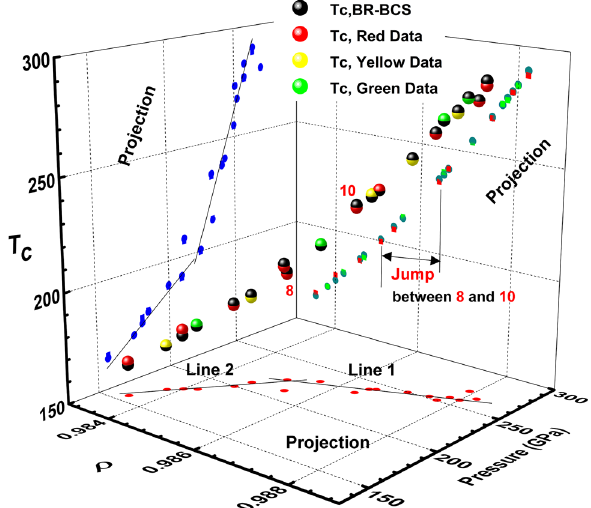
Figure 3. The BR-BCS T c of Eq. (6) and data in Fig. 1a are drawn together. The T c calculations cannot be correct, because the Debye temperature, Θ D , is not correct; here Θ D = 1250 K was predicted in a hydride 1 , which indicates that Eq. (6) approaches the room-temperature T c . The jump in ρ is observed as evidence of the first-order IMT. The detailed information is provided in Table 1. At line 1 over P transition ≈ 220 GPa, the relation between ρ and pressure P is P = 11,759.62 ρ − 11,359.59, where the slope has a standard error of 747.35 and the standard error of the intercept is 737.64. At line 2 below P transition , the relation between ρ and pressure is given as P = 25,230.15 ρ − 24,644.25, where the slope has a standard error of 4660.97 and the standard error of the intercept is 4588.50. The slope of line 1 is much larger than that of line 2, revealing the diverging